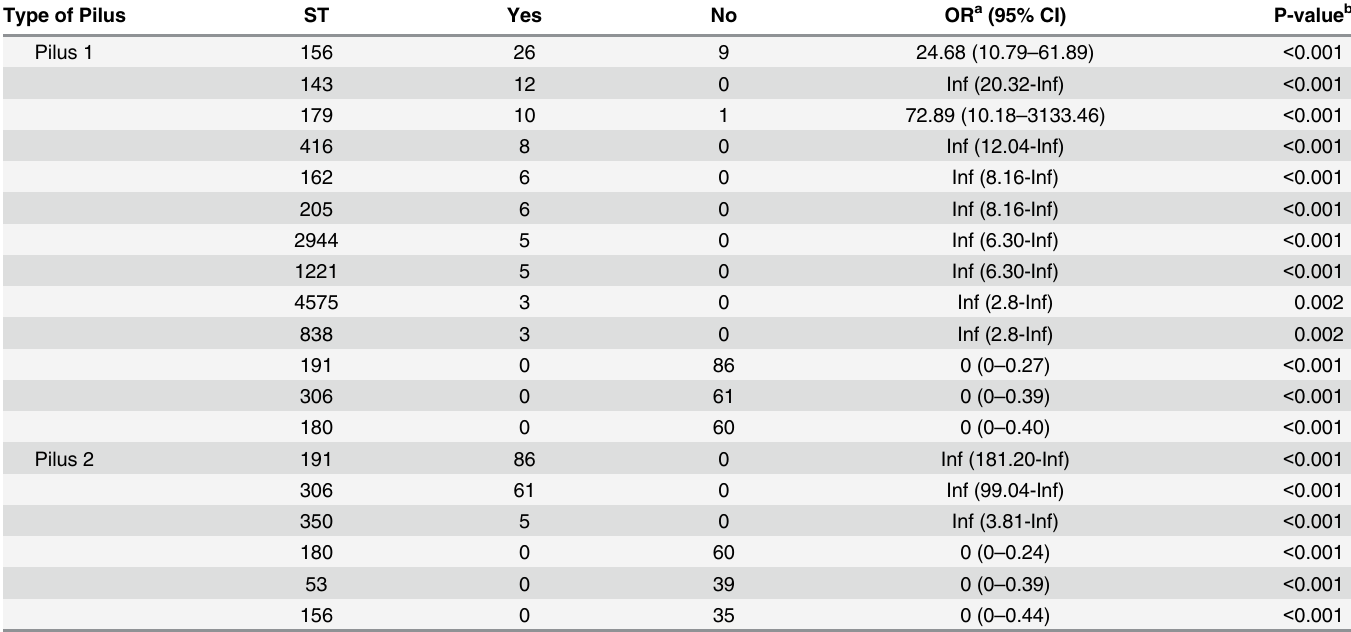
Table 3. Sequence types that were associated with pilus island 1 (PI-1) and pilus island 2 (PI-2). Type of Pilus Pilus